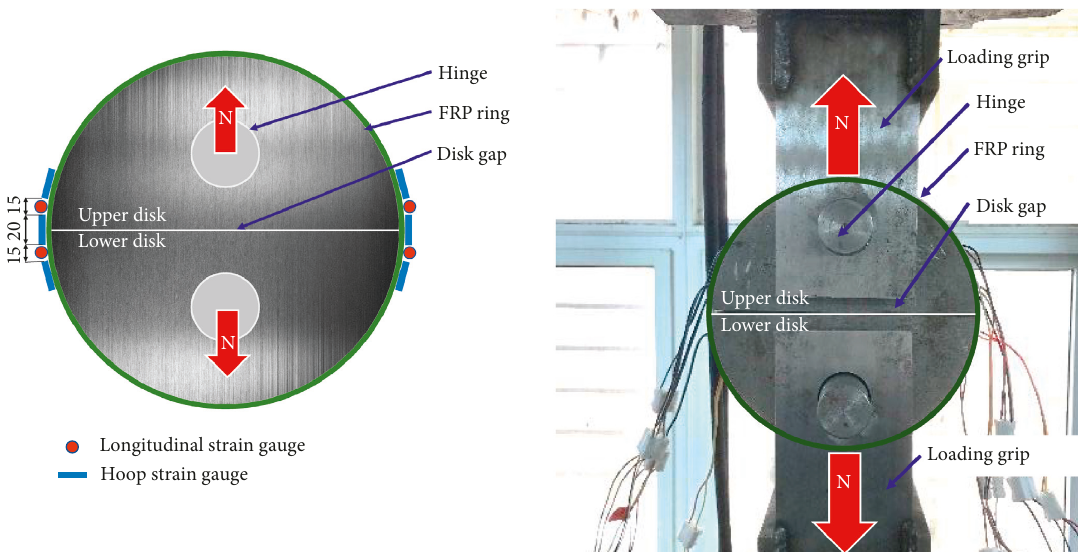
Figure 3: Experimental setup for the split-disk